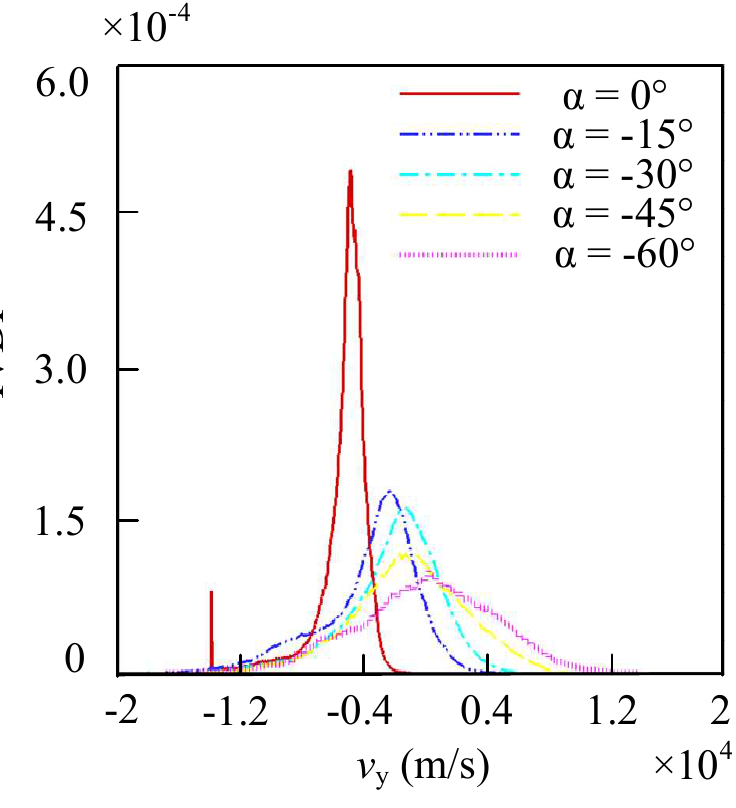
Figure 13. Ion velocity distribution function for radial component with different values of the negative α . The difference in IVDF for radial components shown in Figures 9 and 13 results in different degrees of sputtering erosion on the dielectric wall. When the value of α is negative, the ions entering the simulation area are slowed down or even reversely accelerated, resulting in a reduction in both the number and energy of ions that can hit the wall. The erosion rate values in Figure 14 are generally smaller than that in the cases of α = 0 and α > 0. Meanwhile, as the value of the negative α decreases, the average velocity of the ions away from the wall increases, and the erosion rate of the dielectric wall induced by the ion sputtering decreases. Therefore, compared with the cases of E ⊥ B and α > 0, having magnetic field lines convex to the anode direction enables better focusing of the ion beam and reduction of the erosion rate. Compared with the case with the electric field E perpendicular to the magnetic field B , when the value of the angle α is − 15 ◦ , − 30 ◦ , − 45 ◦ , and − 60 ◦ , the erosion rate decreases by 5.5%, 59%, 83%, and 90%,